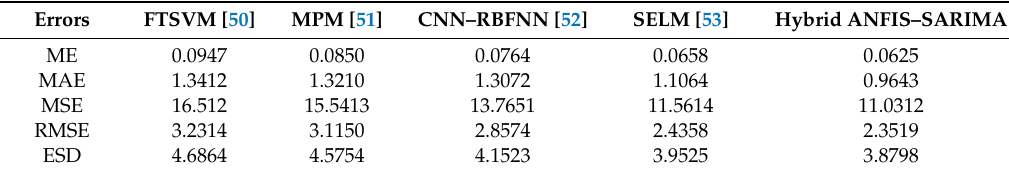
Table 2. Error comparison with state-of-the-art methods for the spring season.